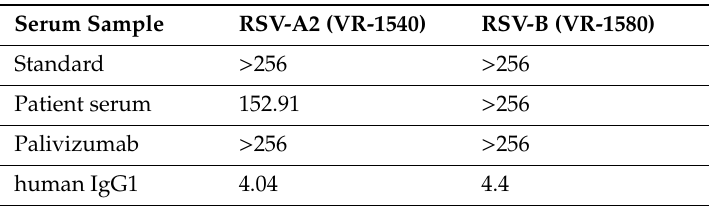
Table 3. RSV-neutralizing titers of di ff erent